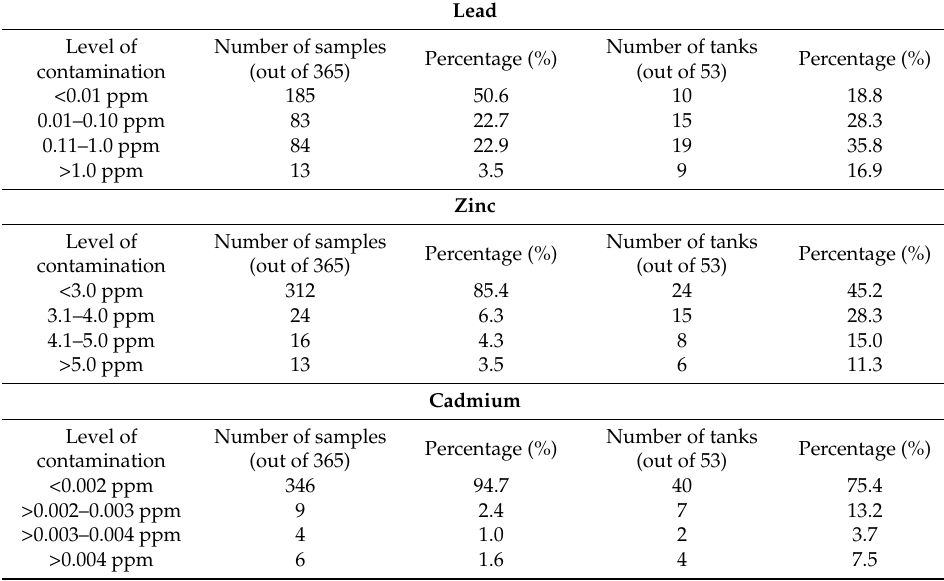
Table 1. Metal levels found in 365 rainwater samples and the number of tanks those samples came from.